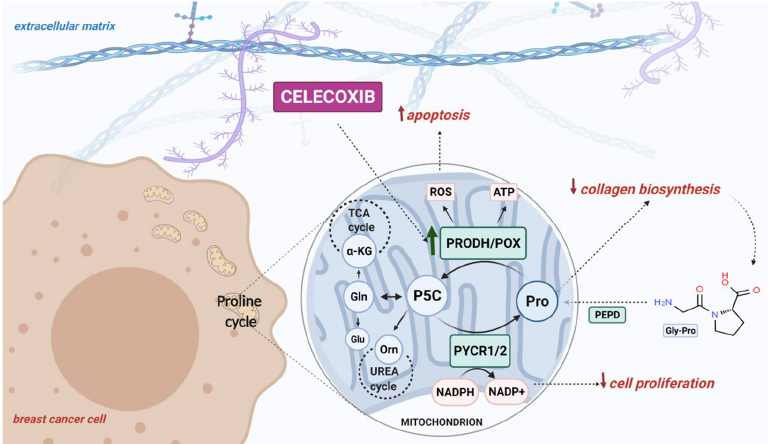
Figure 5. Schematic overview of the PRODH/POX-dependent celecoxib-induced apoptosis in MCF-7 breast cancer cells. Created with BioRender.com. 3. Discussion Celecoxib is a selective COX-2 inhibitor, and it is known that Cx exhibits anticancer effects in models in vitro and in vivo, including colon, lung, and prostate cancer; however,